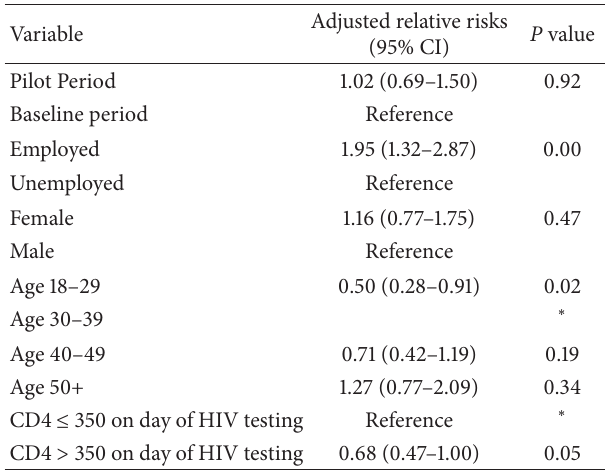
Table 3: Relative risks of returning to wellness program for patients with CD4 > 250 on the day of testing